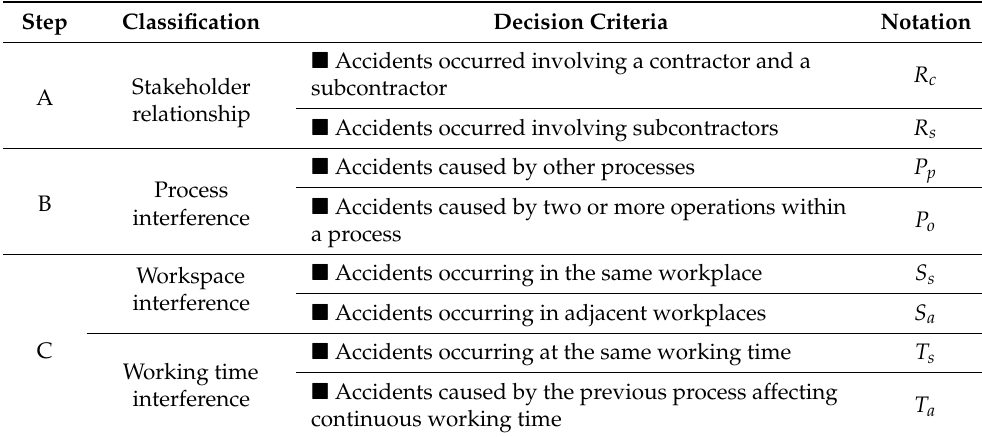
Table 2. Decision process criteria and notation of multiple processes in the workplace.